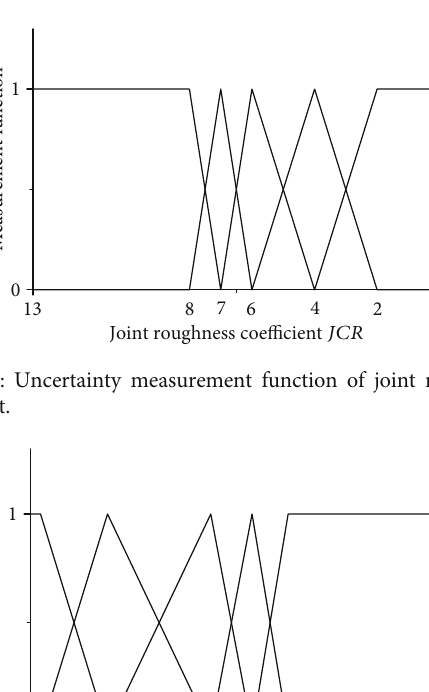
Figure 7: Uncertainty measurement function of joint dip angle.